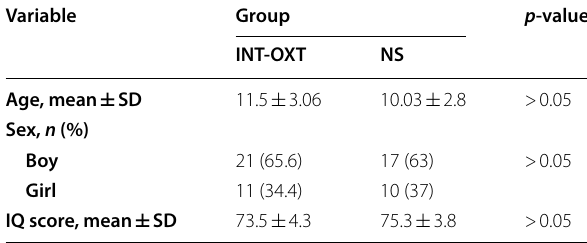
INT-OXT intranasal oxytocin, NS normal saline, IQ intelligence quotient. The IQ was measured using the Raven test. Categorical data were compared using chi-square, and the repeated-measure ANOVA model was used for continuous parameters